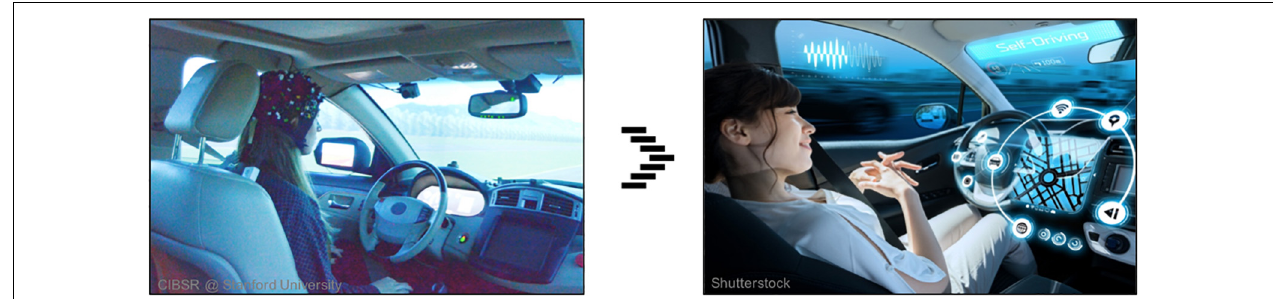
FIGURE 1 | The future of automobile travel may remove control from the human driver all together, allowing drivers to become passengers who are able to engage in other, driving-unrelated tasks. Results from fNIRS brain imaging studies (left) will provide vital insights that may be integral in the design of future automated systems (right) . Written informed consent was obtained from the individual for the publication of any potentially identifiable images included in this